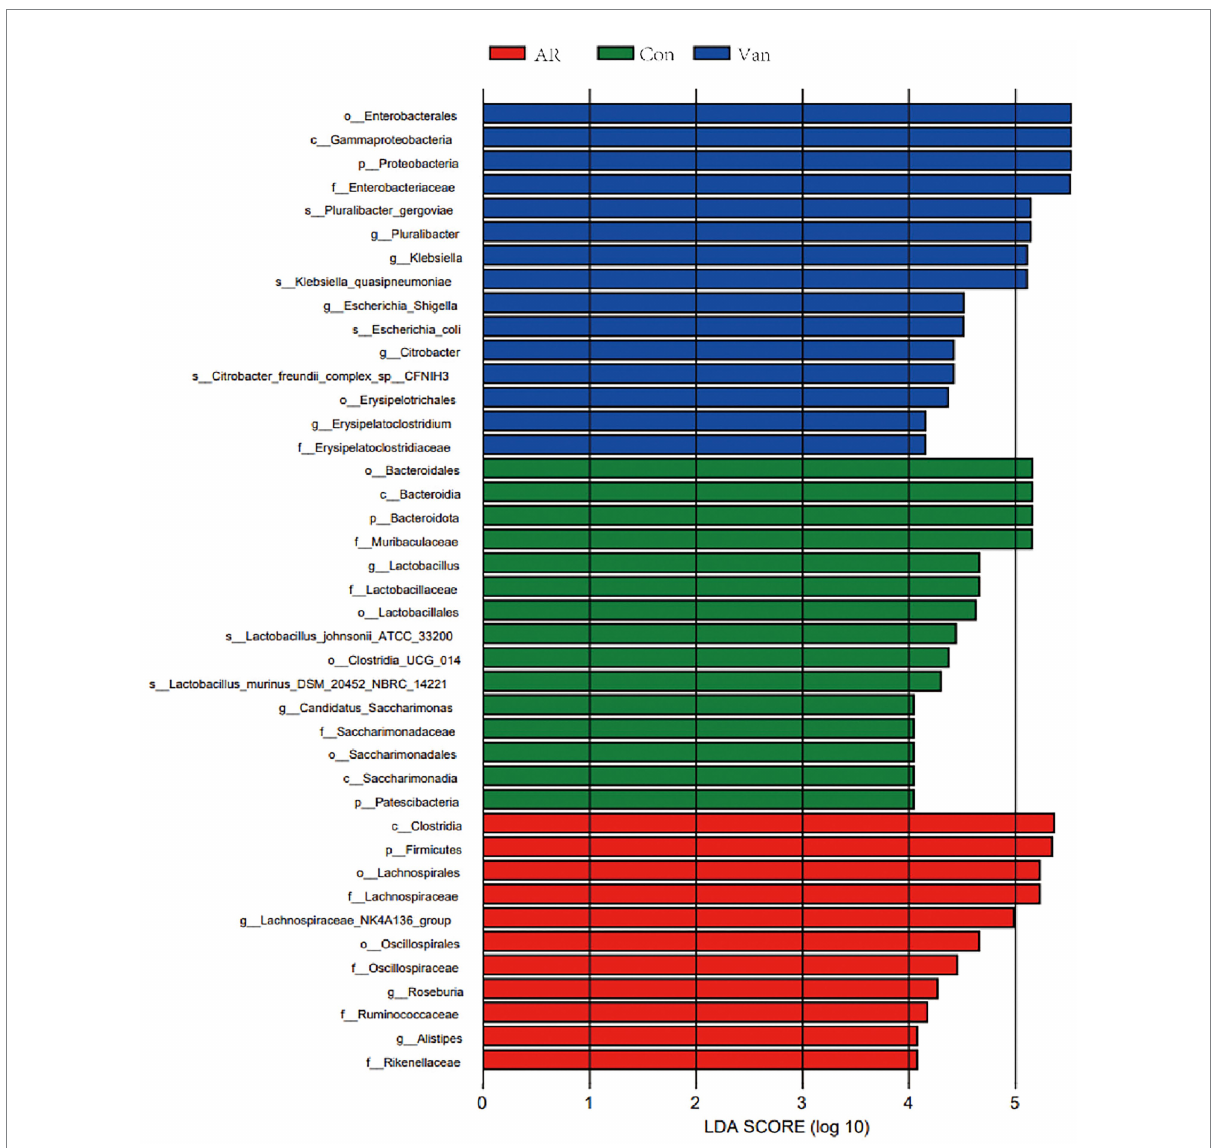
FIGURE 7 Discriminative taxa among the three groups. LDA (Linear discriminant analysis) image shows the differential bacterial genus in each group. The length of the column represents the effect of differential species on this sample (an LDA effect value of more than